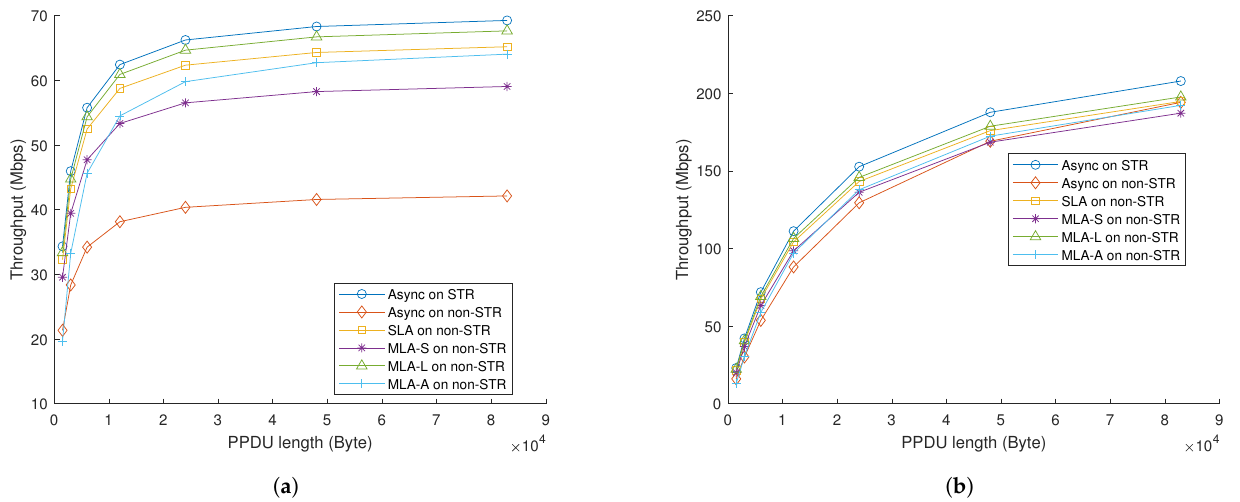
Figure 14. Sum of saturated throughput depending on PPDU length ( a ) when RTS/CTS exchange is off, and ( b ) when RTS/CTS exchange is